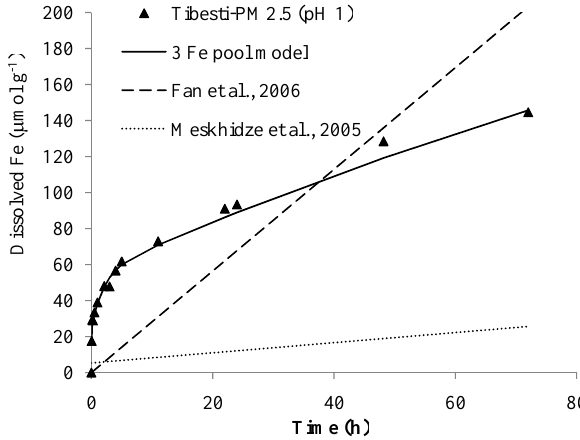
Fig. 8. Comparison of Fe dissolution curves predicted from rate constants used in Meskhidze et al. (2005) and Fan et al. (2006), and the actual measured ones for Tibesti-PM 2 . 5 at pH 1 at 60mgL − 1 . The curve to fit the measured data was from the 3-Fe pool model in this study. In Fan et al. (2006), the production of dissolved Fe from hematite, R Fe (grams of Fe dissolved per gram of hematite Fe per second) was calculated as R d AnM/w , in which R d is the disolution rate in a unite surface area (assumed to be 4 × 10 − 11 molm − 2 s − 1 ) , A is the surface area of hematite (assumed to be 100m 2 g − 1 ) , n equals to 2 (moles Fe/mol hematite), M is molar mass of Fe (55.8 g mol − 1 ) , w is the mass fraction of Fe in hematite (0.7). R Fe was then re-calculated to µmol Fe per g of dust (assuming the mass fraction of hematite to be 6.86% of dust mass as in the Tibesti-PM 20 sample) for comparison with the data in this study. In Meskhidze et al. (2005), the rate of dissolution of mineral, R , in mol hematite dissolved per g of dust per second was calcu- lated as K r ( T )a (H + ) m f (1G r )AW , in which a (H + ) is the activ- ity of H + (0.1 at pH 1); m is an empirical parameter (0.5); and f is a function of Gibbs free energy, 1G r , which accounts for the variation of the rate with deviation from equlibrium. f (1G r ) = 1 − Q/K eq in which Q is the hematite dissolution activity quotient ) and K eq is 0.44. a Fe3 + was assumed to be the (i.e., a Fe3 + / a 3 H + concentration of Fe 3 + (molL − 1 ) and calculated at the condition of 60mgL − 1 ; A is the surface area of hematite (100m 2 g − 1 ) ; W is the weight fraction of the mineral in dust in units of g of mineral per g of dust (0.0686g hematite per g dust as in Tibesti-PM 20 ) ; K r (T ) is the dissolution rate (1.8 × 10 − 11 exp[9.2 × 10 3 (1/298 − 1/ T )] mol m − 2 s − 1 ; note that this is the second stage dissolution rate in Meskhidze et al. (2005). This is chosen to address the fact that there is an extractable Fe pool (assumed to be FeA in this calculation) in the original dust as treated in Solmon et al., 2009), and T is temperature ( ∼ 298K in this work). The rate of dissolution of Fe (molm − 2 s − 1 ) was two times of R (2 moles of Fe in 1 mole of hematite). Note that in both Meskhidze et al. (2005) and Fan et al. (2006), all Fe in the dust was assumed to be hematite only. Also note that Meskhidze et al. (2005) assumed that the net daytime rate of hematite dissolution is 5–10 times greater than that calculated using the standard kinetics described above but no change is made to the nighttime